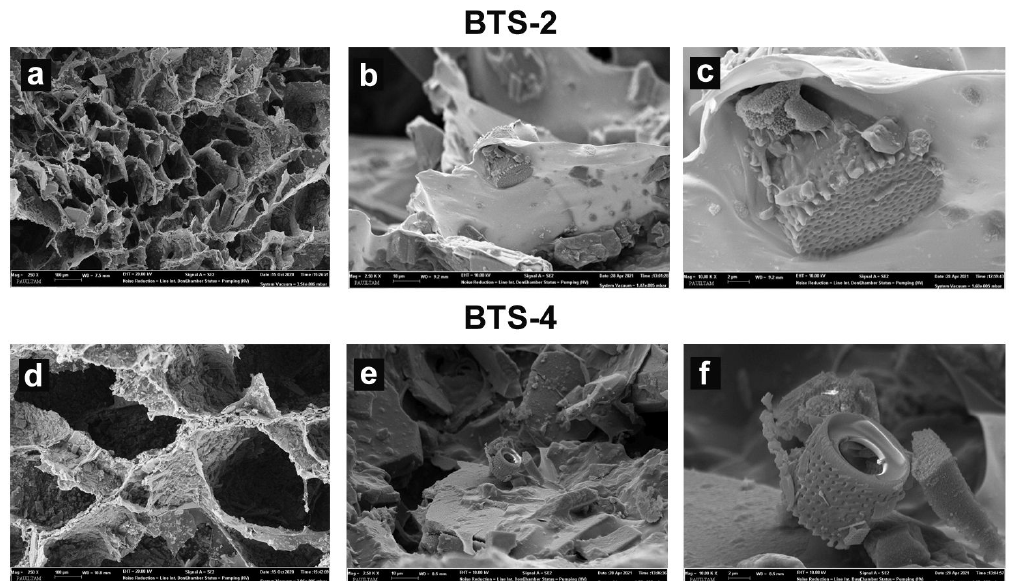
Figure 3. Morphological images of diatom BTS-2 scaffold (a) 250x, (b) 2500x, (c) 10000x and BTS-4 scaffold (d) 250x, (e) 2500x, (f) 10000x.